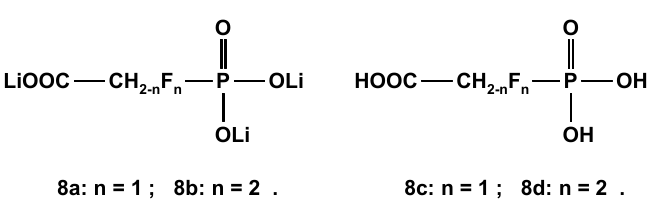
8a: n = 1 ; 8b: n = 2 . 8c: n = 1 ; 8d: n = 2 .